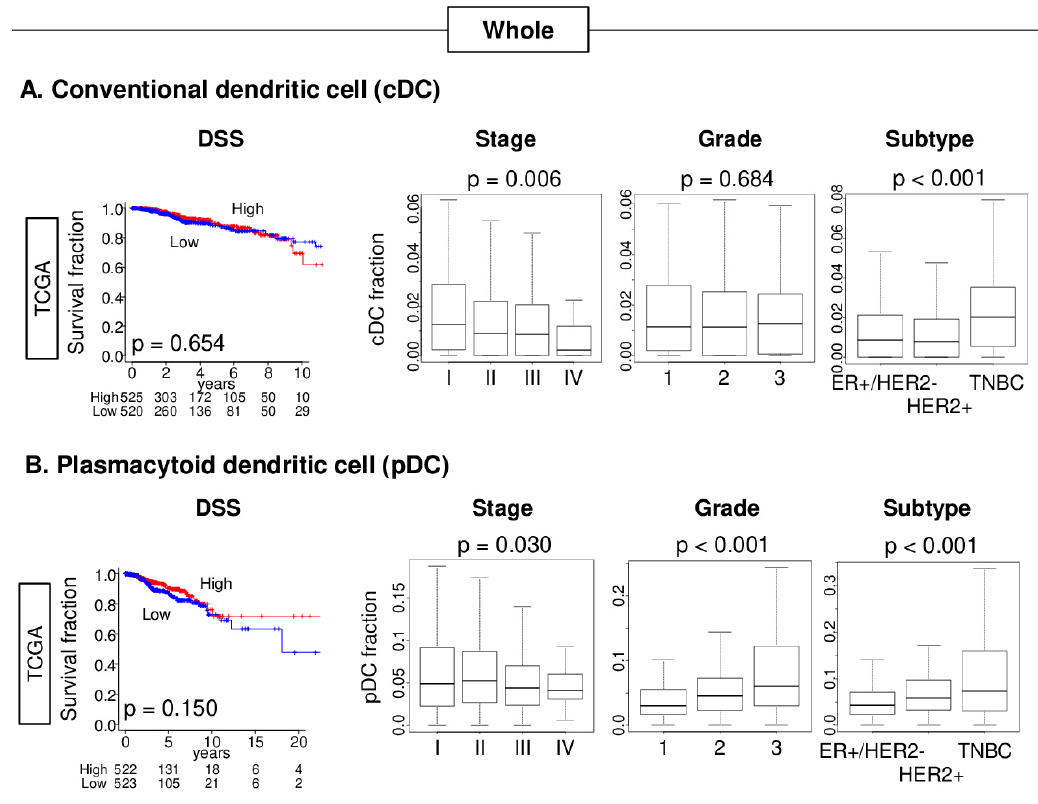
Figure 1. Association of cDCs and pDCs with clinical features in the TCGA cohort. Kaplan–Meier survival (disease-specific survival [DSS]) curves and boxplots of the AJCC stage, Nottingham pathological grade, and subtype with ( A ) cDCs and ( B ) pDCs. The Kaplan–Meier curve shows the DSS of cDCs and pDCs, low (blue) and high (red), with a p -value of the log rank test. Median was used as the cut-off to divide patients into low and high groups within each cohort. Tukey type boxplots showed median and inter-quartile level values, and the one-way ANOVA test was used to calculate p values.